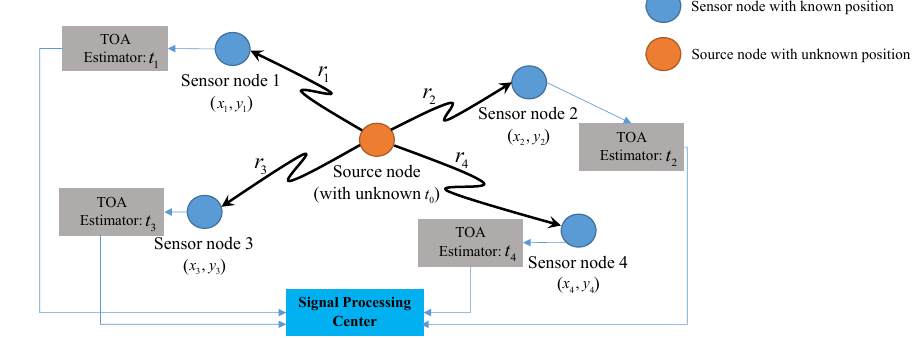
Figure 1. Asynchronous time-of-arrival (TOA)-based source